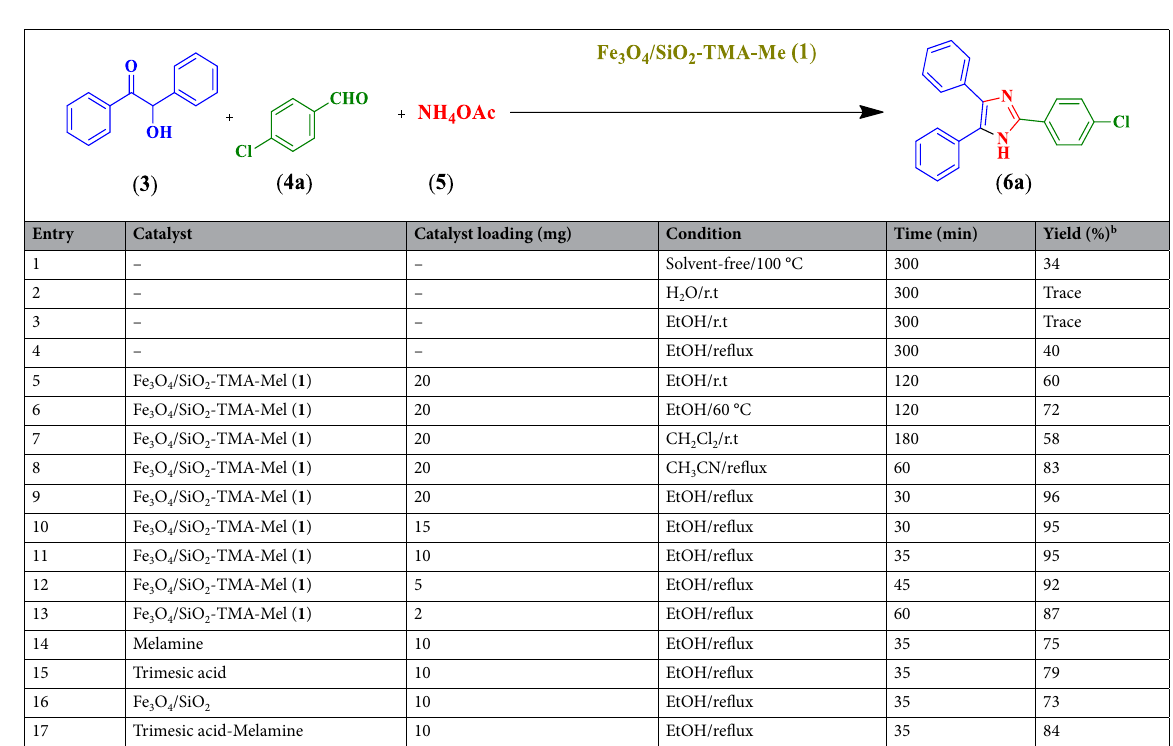
Table 1. Optimization of conditions in the model reaction of benzoin ( 3 ), 4-chlorobenzaldehyde ( 4a ), ammonium acetate ( 5 ) under different conditions in the presence of the Fe 3 O 4 /SiO 2 -TMA-Me solid acid ( 1 ).